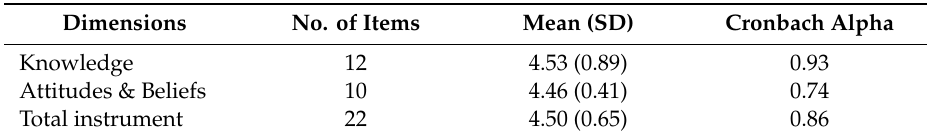
Table 5. Average item scores and Cronbach alpha reliabilities for the general KAB instrument and dimensions ( n = 187).